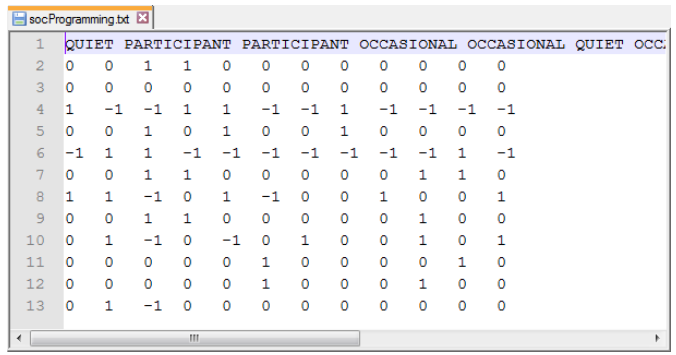
Figure 3. Initial sociogram represented with a text file.